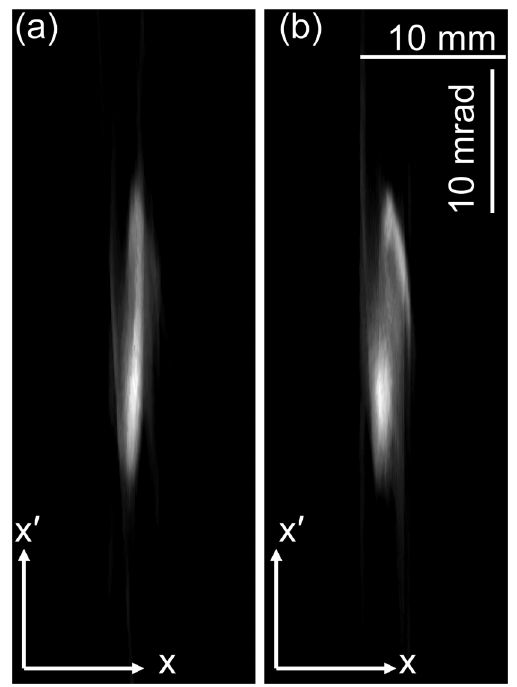
FIG. 3. Beam phase-space distribution in x - x 0 within a 10 ns gate centered around the perturbation, recovered by tomography and backprojected to the gun aperture ( z ¼ 0 cm ). (a) Without, and (b) with the perturbation. The subtracted slope (cid:6) is shown in Table II.